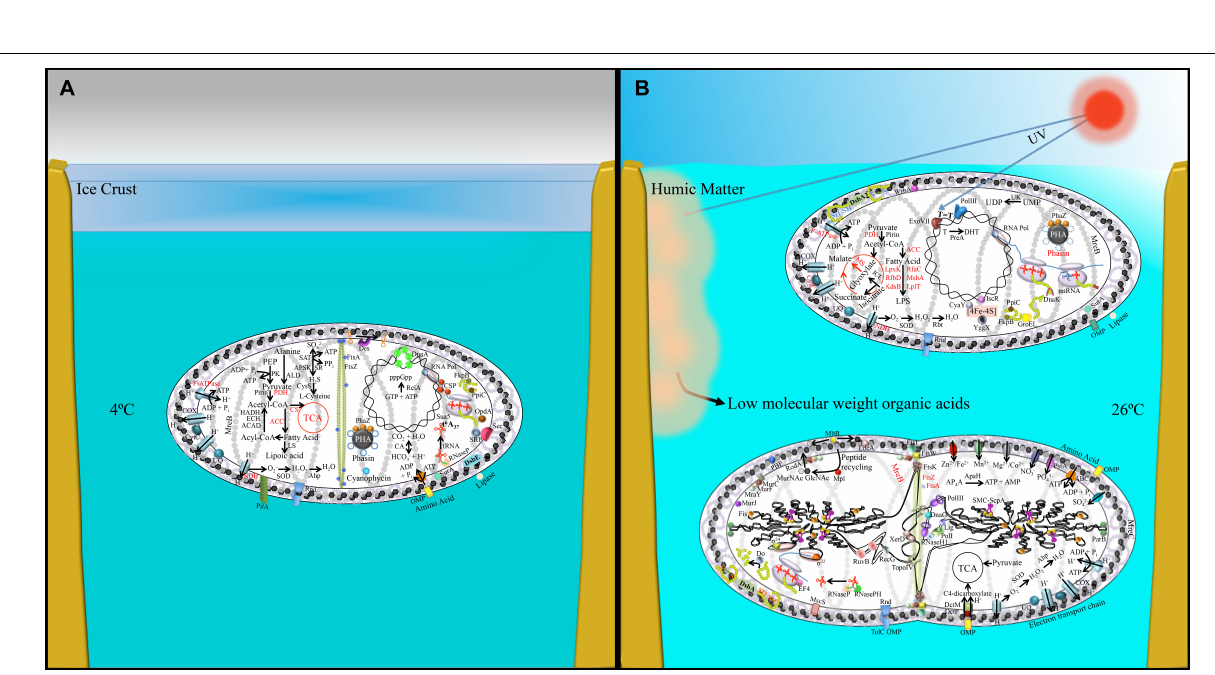
FIGURE 5 | Pictorial representation of transcriptomic and proteomic data obtained from (A) 4 ◦ C-incubated bacterial sample and (B) UV-irradiated (upper cell), 26 ◦ C-incubated bacterial sample (lower dividing cell). This figure is a lifestyle inference and shows possible physiological changes together with the involved genetics in P. asymbioticus strain QLW-P1DMWA-1 T during winter and summer. Black font: up-regulated genes/protein; red font: down-regulated genes/proteins. Abbreviations explained in Supplementary Table S5 . Model of humic matter photolysis into low-molecular-weight photo-oxidation products and its utilization by these bacteria has been modified after Hahn et al.